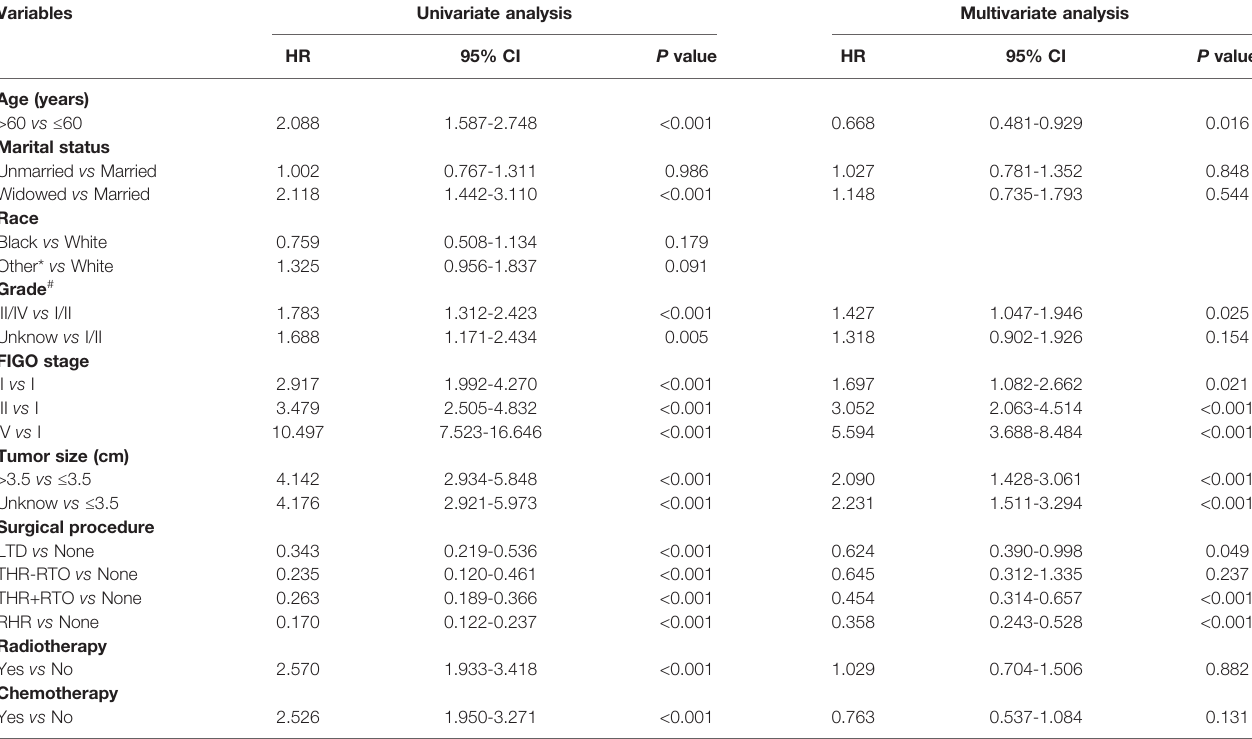
TABLE 2 | Univariate and multivariate Cox analyses for CSS of ASCC patients in the training